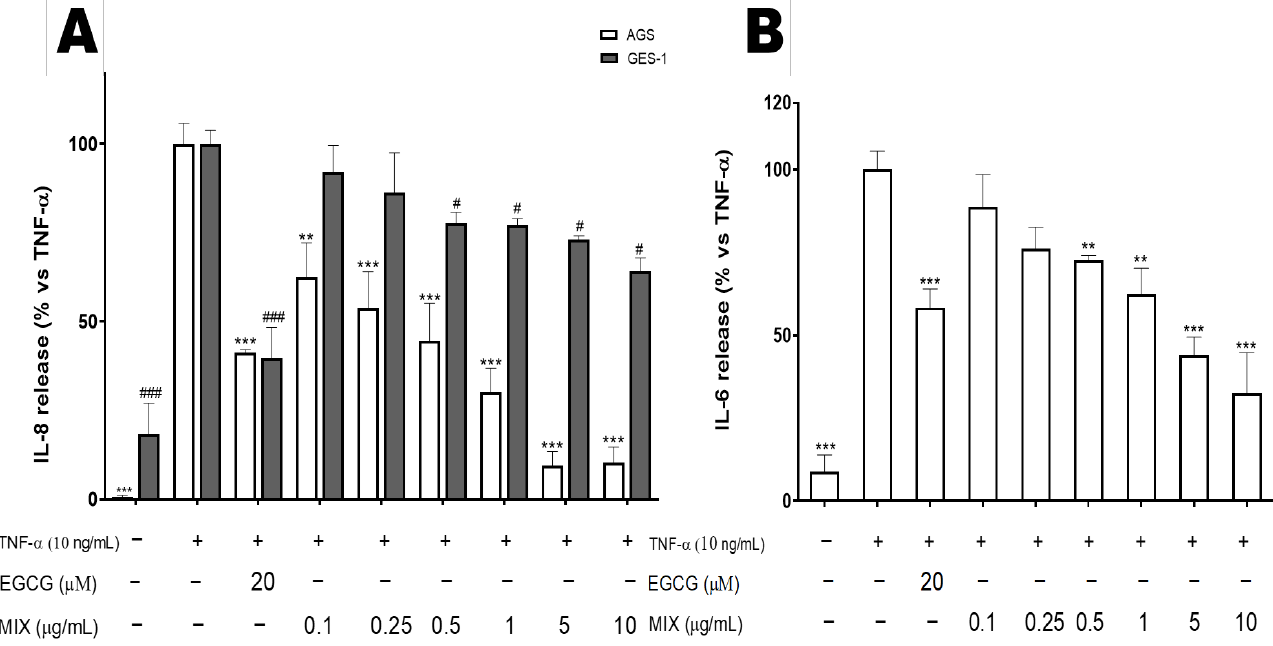
Figure 2. Effect of the MIX on the TNF α -Induced IL-8 ( A ) and IL-6 ( B ) release in human gastric adenocarcinoma (AGS) and gastric epithelial (GES-1) cells. Data are expressed as percentages versus the stimulated control, which is arbitrarily set to 100%. ** p < 0.01; *** p < 0.001 in AGS cells and # p < 0.05, and ### p < 0.001 in GES-1 cells. EGCG: Epigallocatechin-3-O-gallate, +: Present, –: Absent.